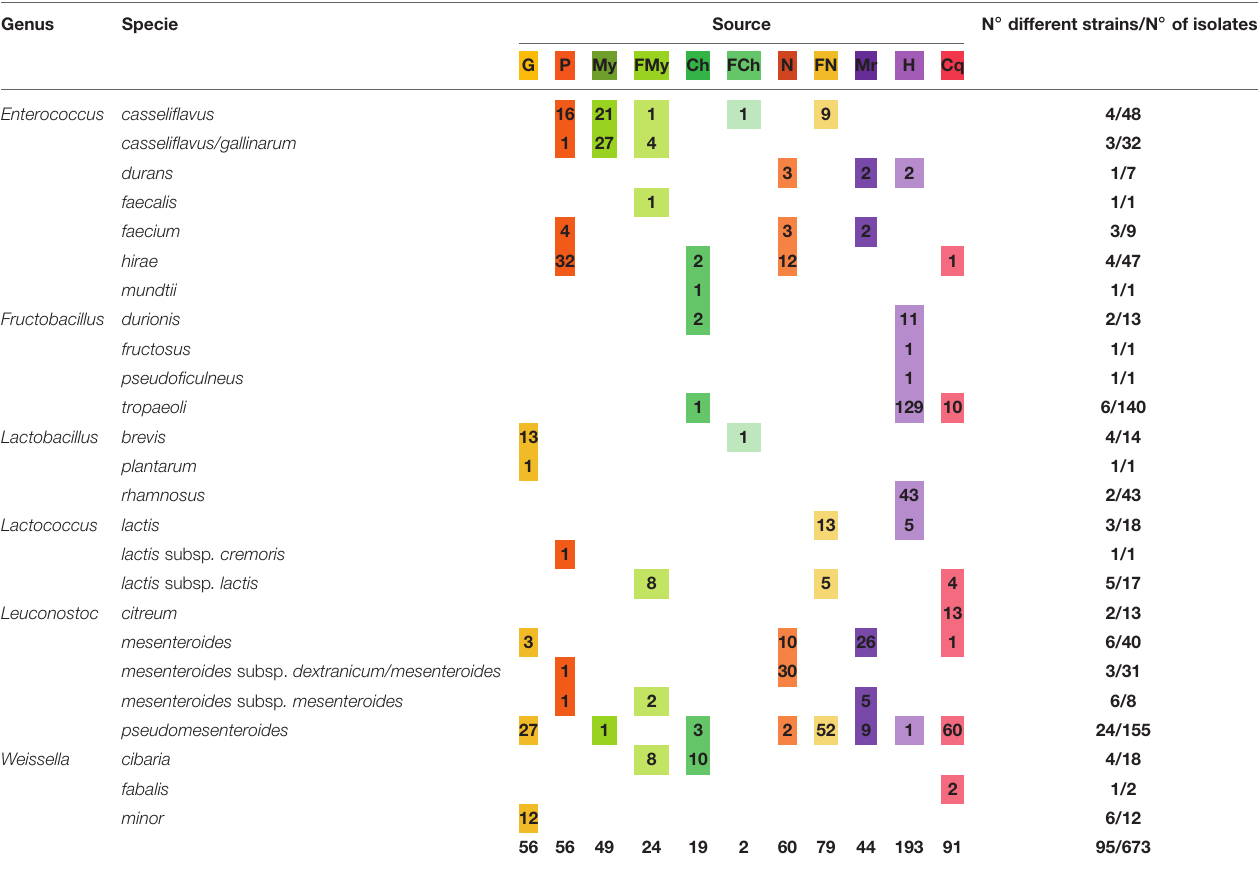
TABLE 3 | Distribution of LAB isolates according to their species and the fruit and flower samples. Genus Specie